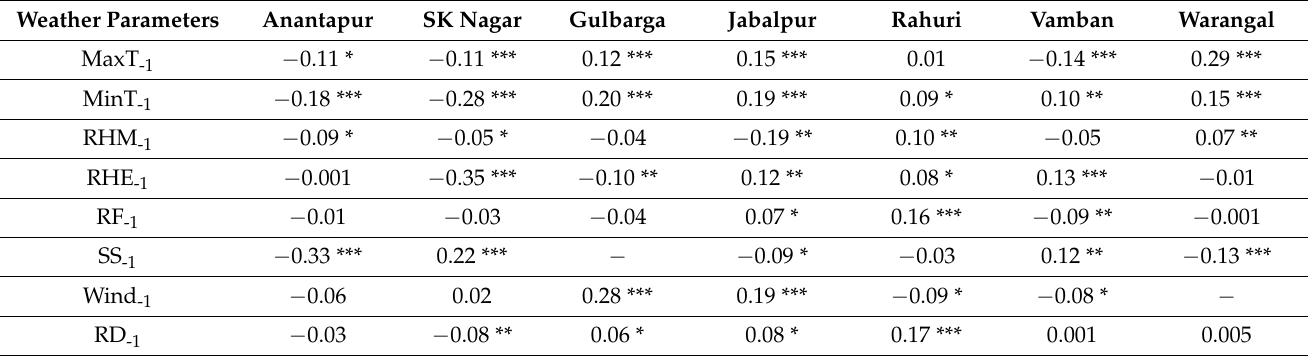
Table 5. Correlation coefficients between spiders with weather factors, lagged by one